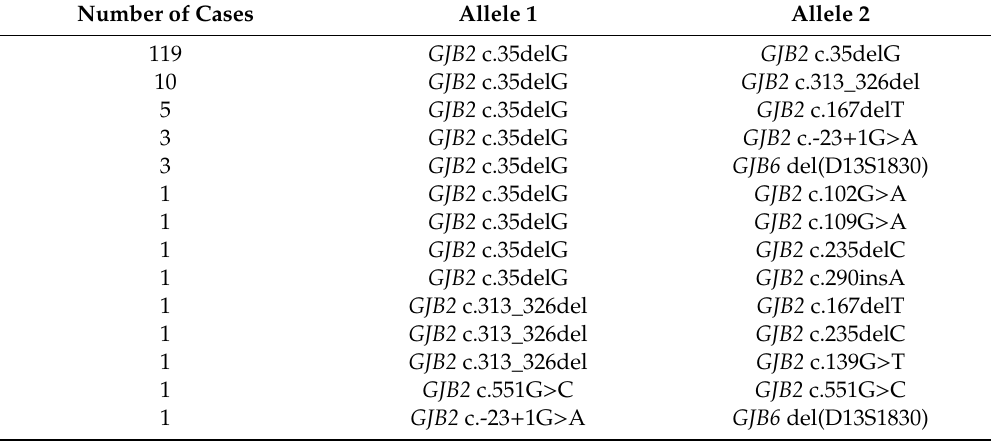
Table 1. Pathogenic variants of the DFNB1 locus detected in tested subjects.